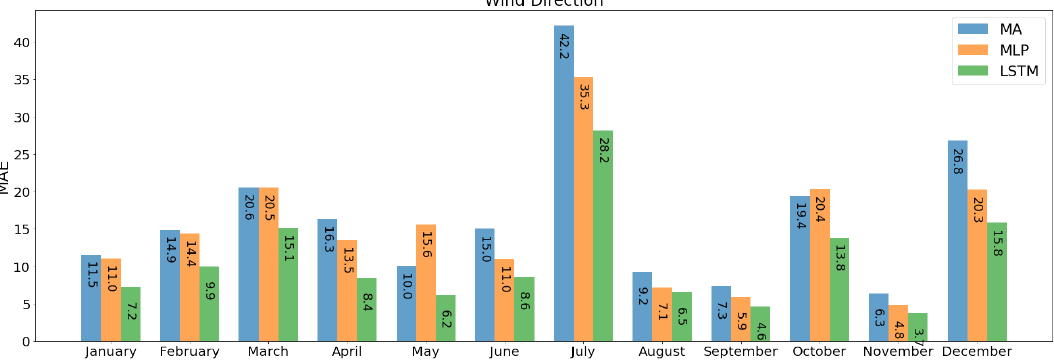
Figure 24. The performance metric (MAE) comparison for wind direction prediction for the whole